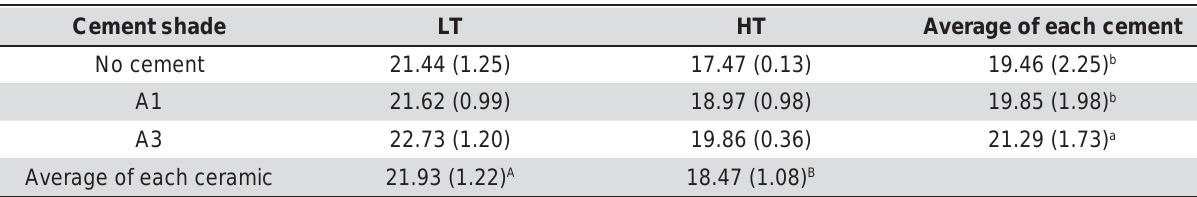
Table 3- Mean of C * (standard deviations) of LT and HT ceramics before and after placement of RC with different shades. ab The means followed by different letters [upper case letters within the columns (ceramic) and lower case letters within the (cid:85)(cid:82)(cid:90)(cid:86)(cid:3)(cid:11)(cid:70)(cid:72)(cid:80)(cid:72)(cid:81)(cid:87)(cid:12)(cid:64)(cid:3)(cid:68)(cid:85)(cid:72)(cid:3)(cid:86)(cid:76)(cid:74)(cid:81)(cid:76)(cid:191)(cid:70)(cid:68)(cid:81)(cid:87)(cid:79)(cid:92)(cid:3)(cid:71)(cid:76)(cid:73)(cid:73)(cid:72)(cid:85)(cid:72)(cid:81)(cid:87)(cid:3)(cid:11)(cid:83)(cid:31)(cid:19)(cid:17)(cid:19)(cid:24)(cid:12)